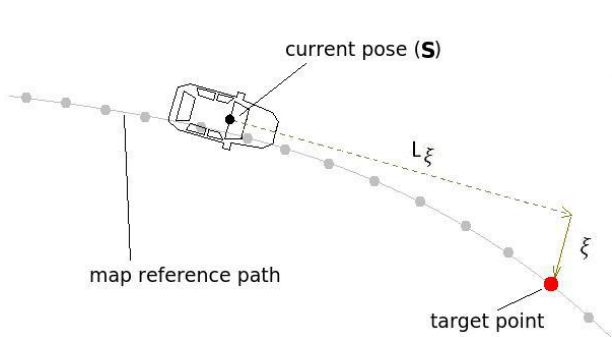
Figure 29. Autonomous drive based on following a forward target point.